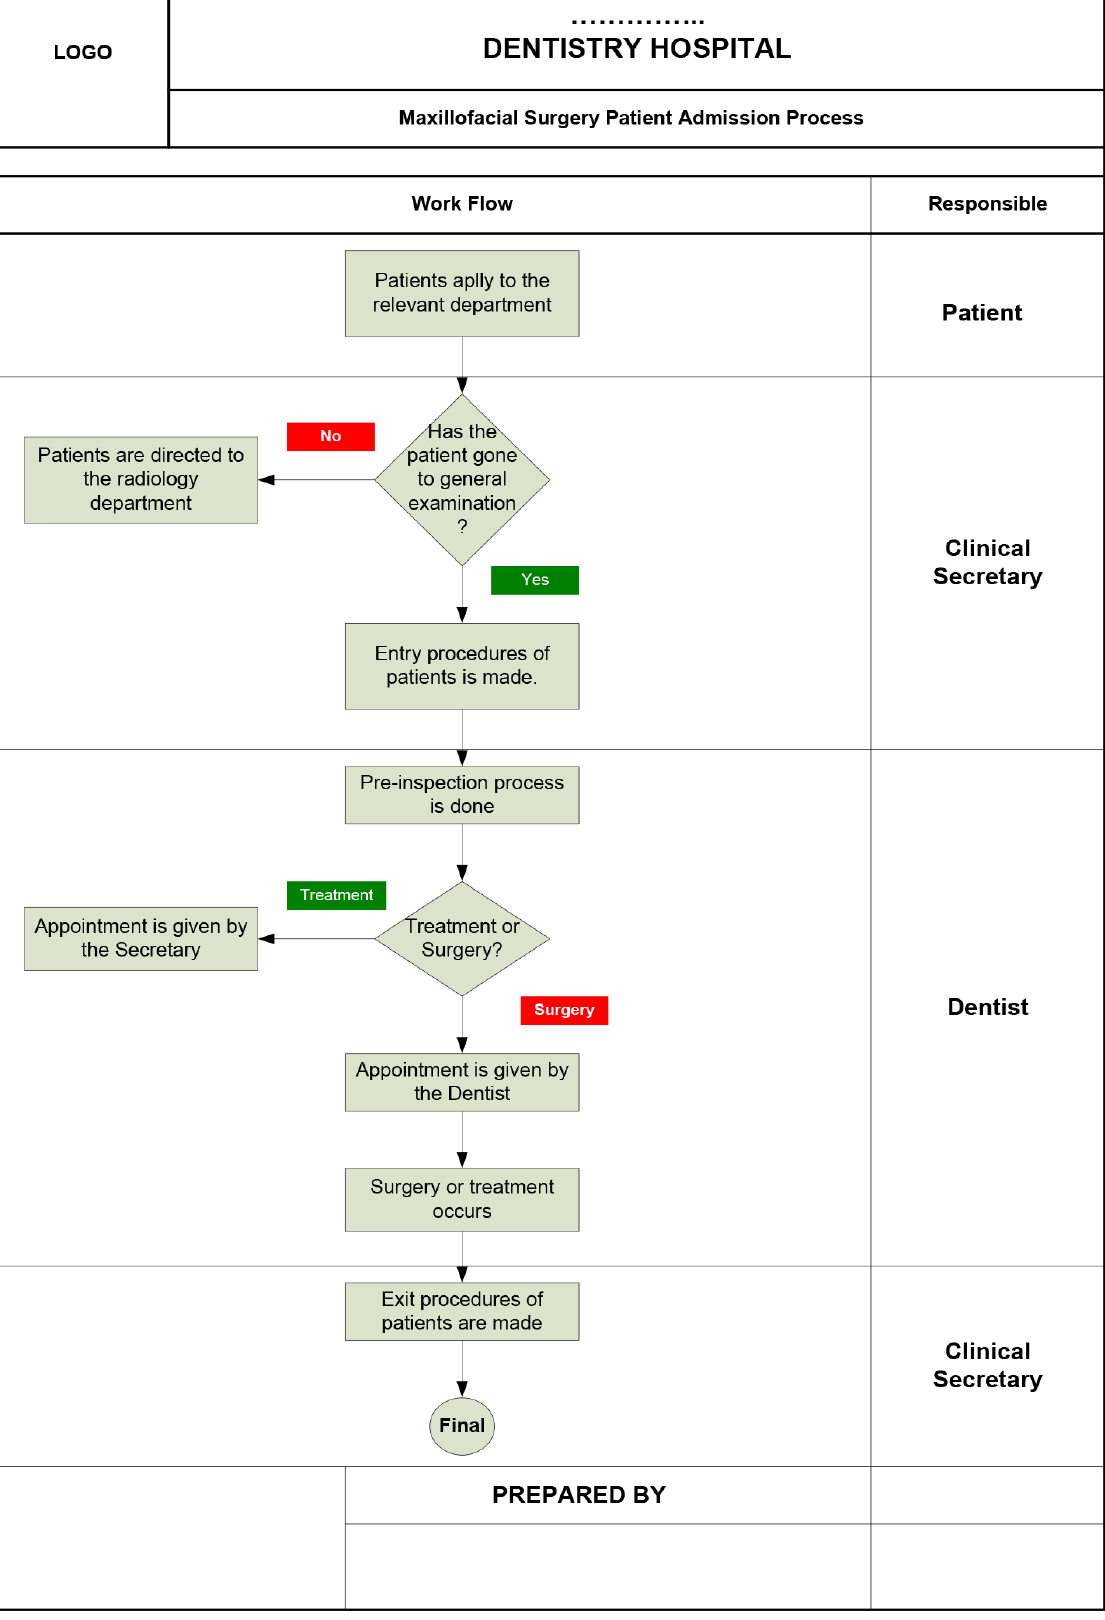
Figure 5. An example of patient admission